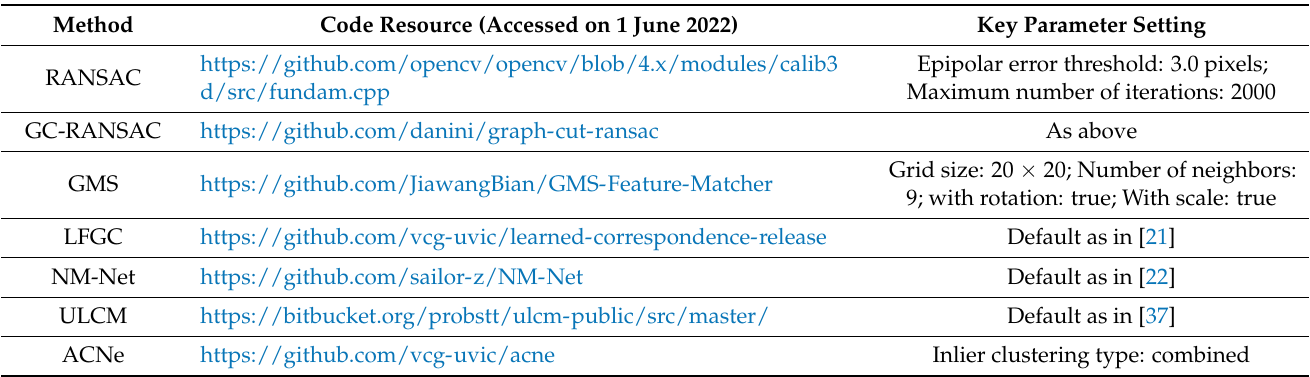
Table 1. Key parameter settings of the compared